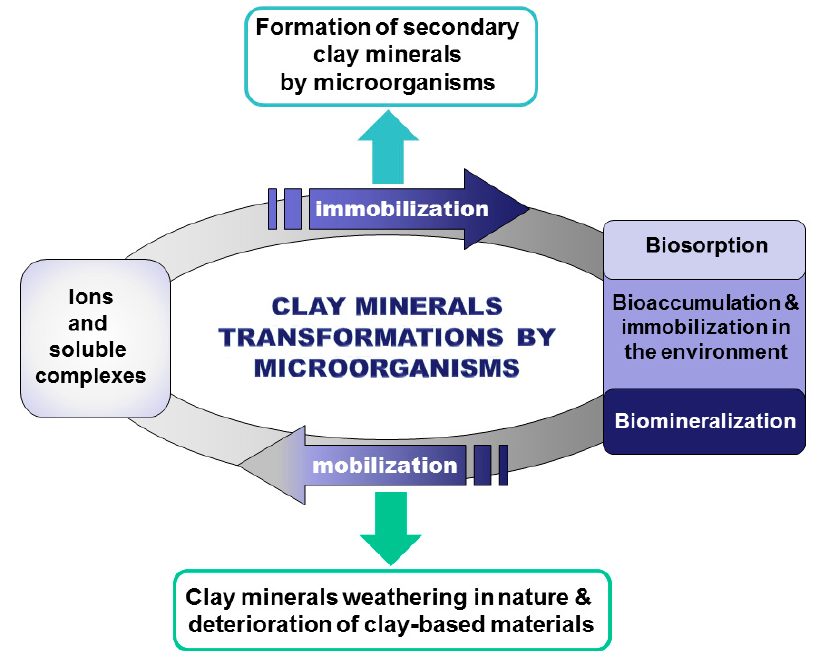
Figure 1. Simplified diagram of the main biogeochemical processes in the transformations of clay minerals by microorganisms.